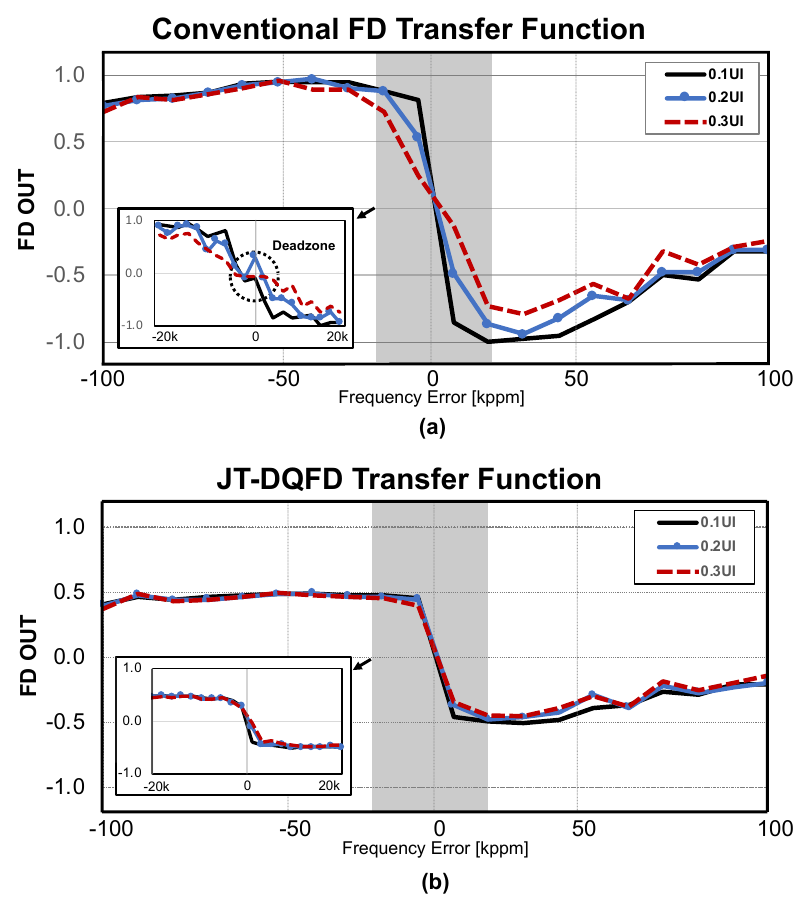
Figure 5. Characteristics of conventional FD and JT-DQFD with respect to the input jitter @ 10